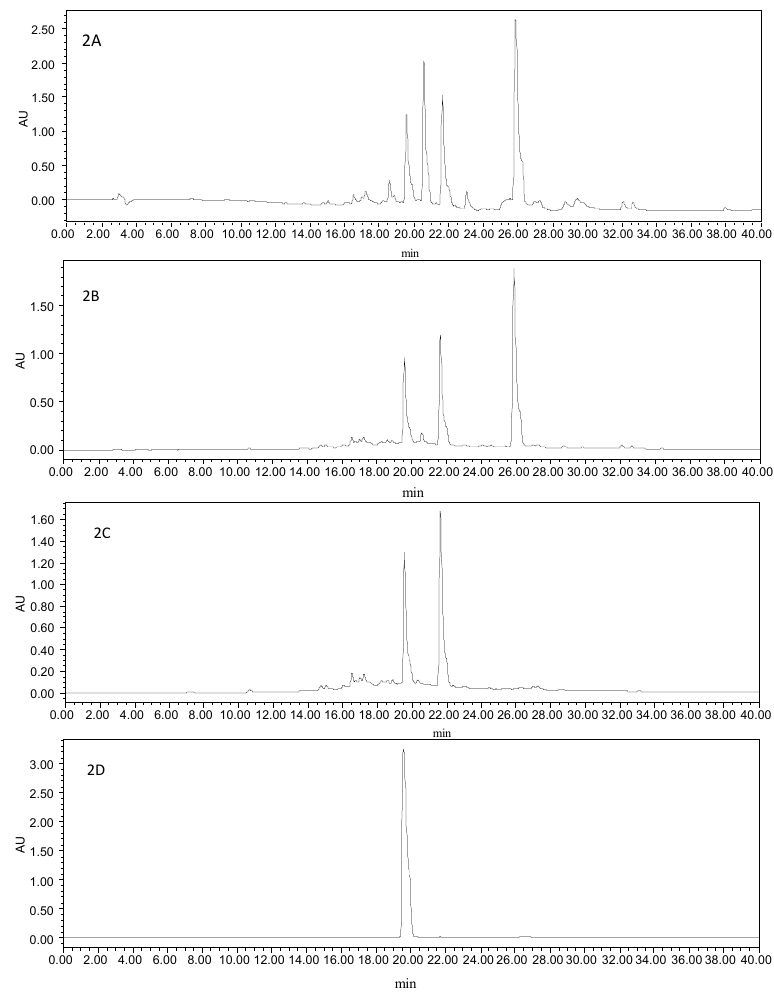
Figure 2. Cont. Figure 2.